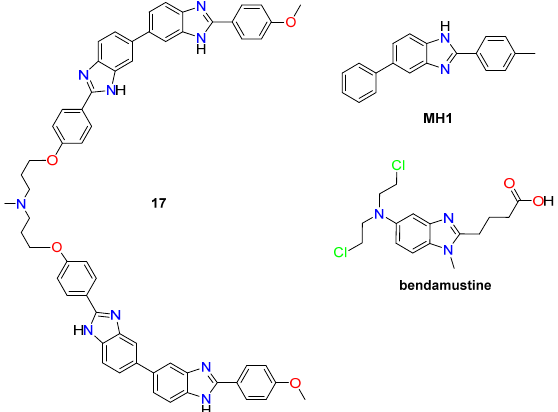
Figure 10. Selected examples of antitumor.